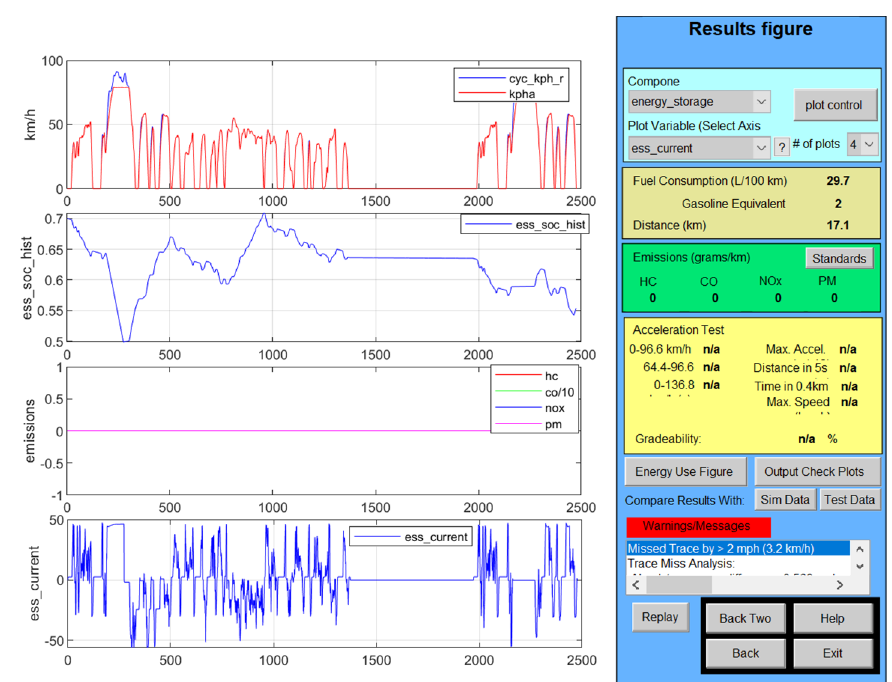
Figure 4. Simulink setup page.